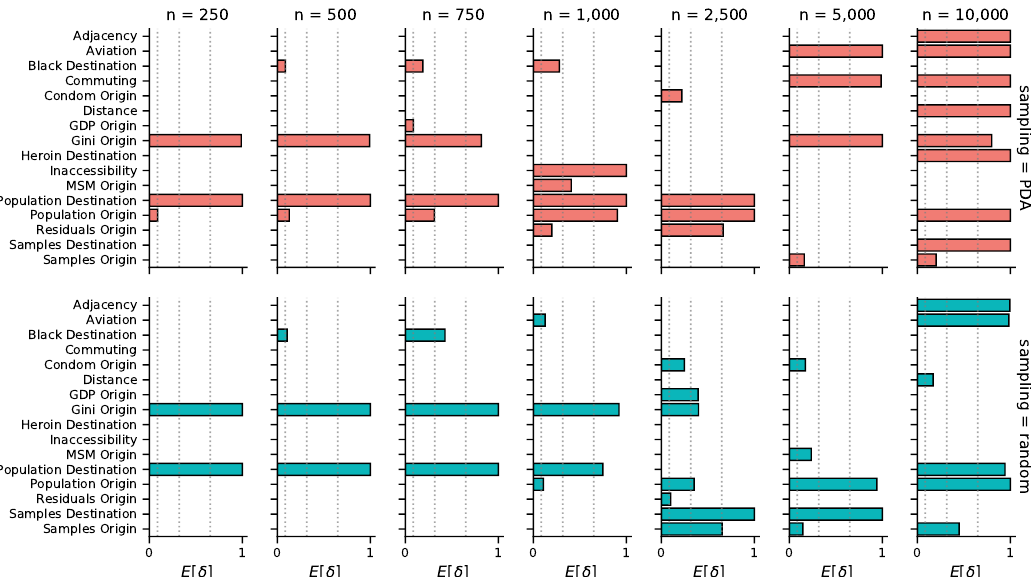
Figure 3. Predictors of HIV-1B spatial spread within the United States by subsample size and sampling scheme (PDA/random). Posterior inclusion probabilities for each predictor are represented in terms of indicator expectations ( E [ δ ] ). Only predictors with a Bayes factor greater than 5 in at least one analysis are displayed. Dotted vertical lines denote inclusion probabilities corresponding to Bayes factors of 5, 25, and 100, respectively. For all inclusion probabilities and a description of each predictor, we refer to Supplementary Materials Figure S5 and Figure S6.